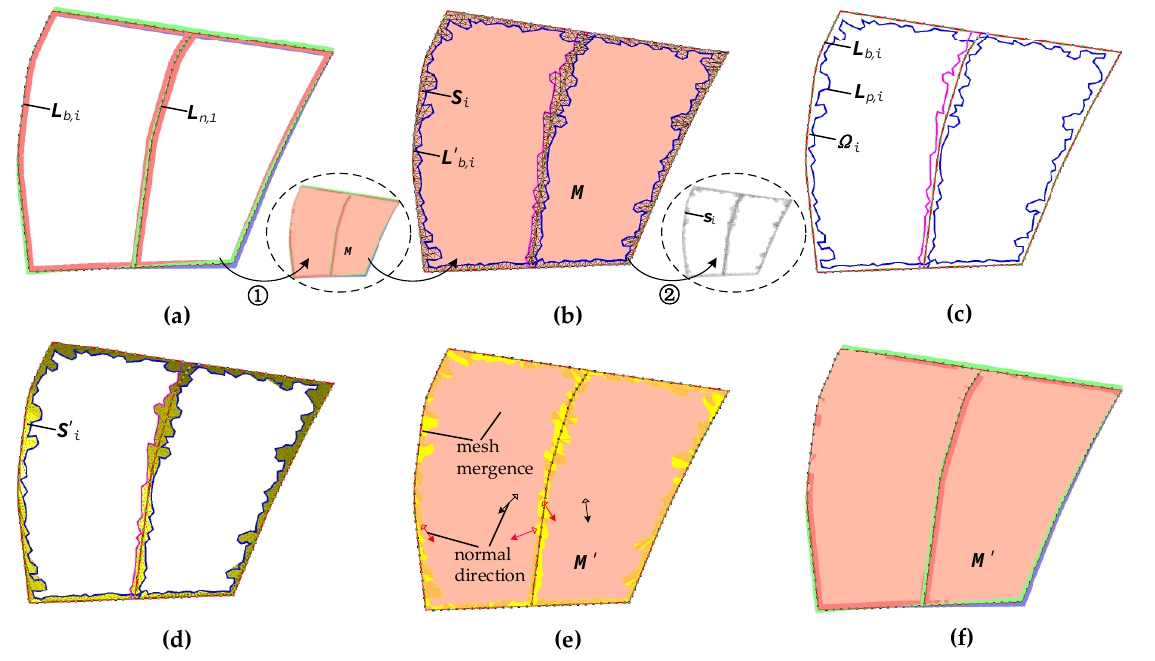
Figure 7. Snapping of boundary constraint polylines. ( a ) shows the boundary constraint polylines and non-boundary constraint polylines. ( b ) shows the process of projecting constraint polylines onto the model and matching the meshes. ( c ) shows the results of deleting the matched meshes and extracting the boundaries of the projective neighborhoods. ( d ) shows the result of re-meshing the projective neighborhoods. ( e ) shows the results of merging all meshes and unifying the normal direction of all triangular patches. ( f ) shows the mesh model after snapping constraint